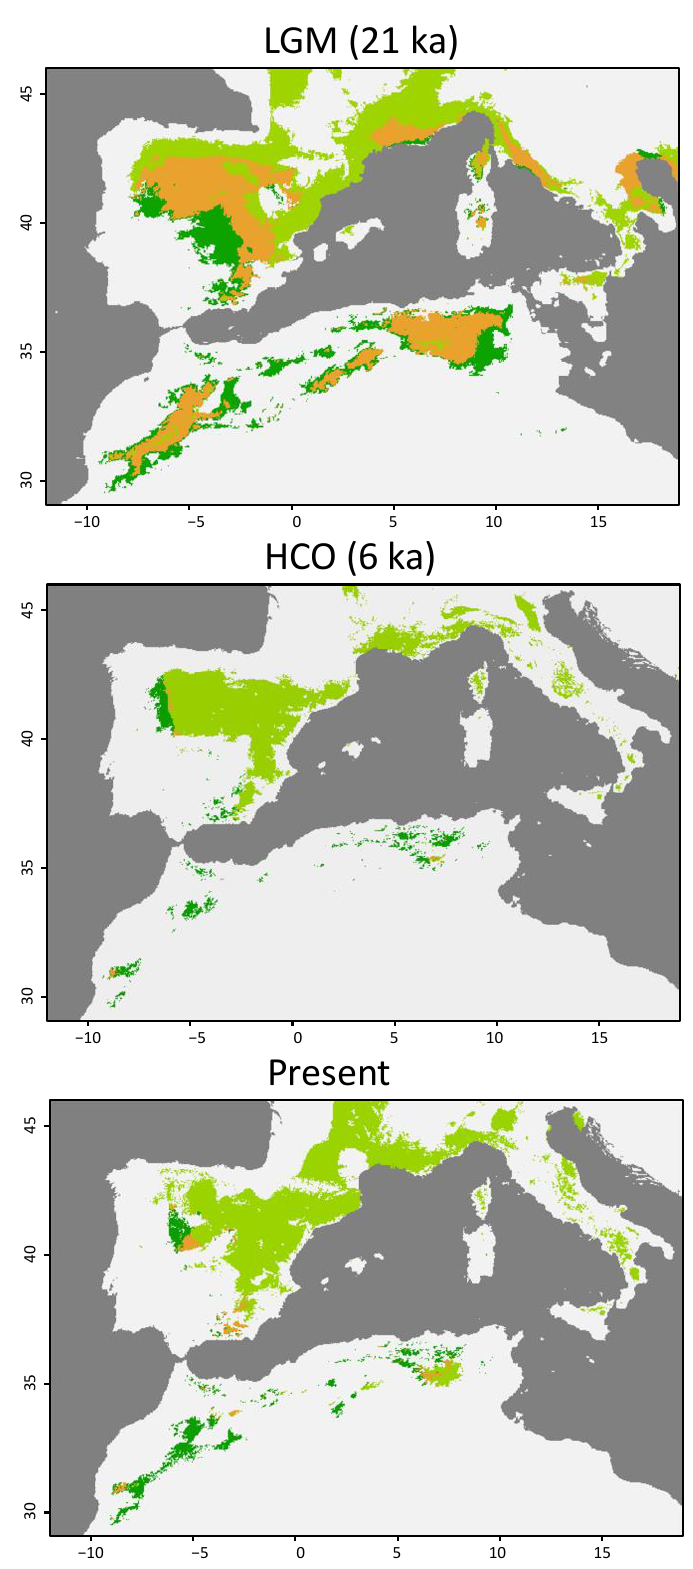
Figure 3. Potential habitat for Pinus nigra , Cedrus atlantica and their overlap in three time periods: ( a ) Last Glacial Maximum; ( b ) Holocene Climatic Optimum; ( c ) present. These were built from the species distribution model (M AX E NT ) with environmental variables from the past according to the MIROC-ESM General Circulation